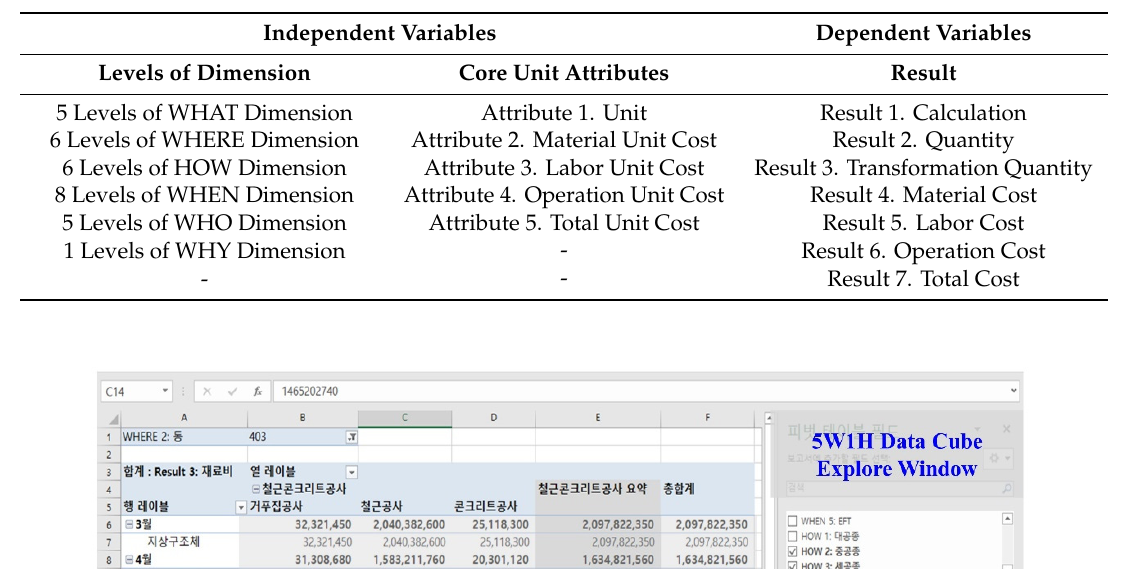
Table 2. Types of Data in the Implemented Database Based on the 5W1H Schema.